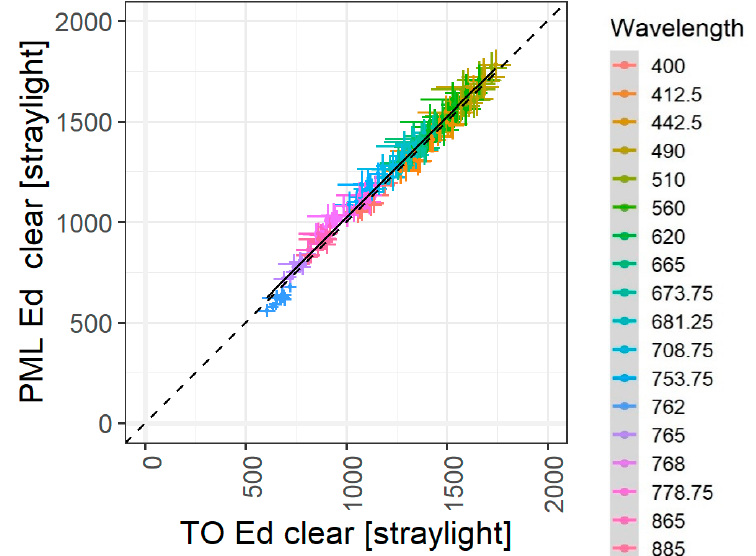
threshold of 1200 mW/m 2 at 560 nm. The resulting dataset was further reduced by rejecting all stations with an expanded uncertainty of 𝐸 (cid:3031) more than 5%. As a result, 10 stations were included in the comparison of 𝐸 (cid:3031) (Figure 8) from the whole dataset (Figure A3). The average 𝐸 (cid:3031) ratio between PML and TO over all 32 stations, together with the expanded uncertainty, is shown in Figure 9. The median of E n numbers of individual station ratios is shown in Figure 10 as well.